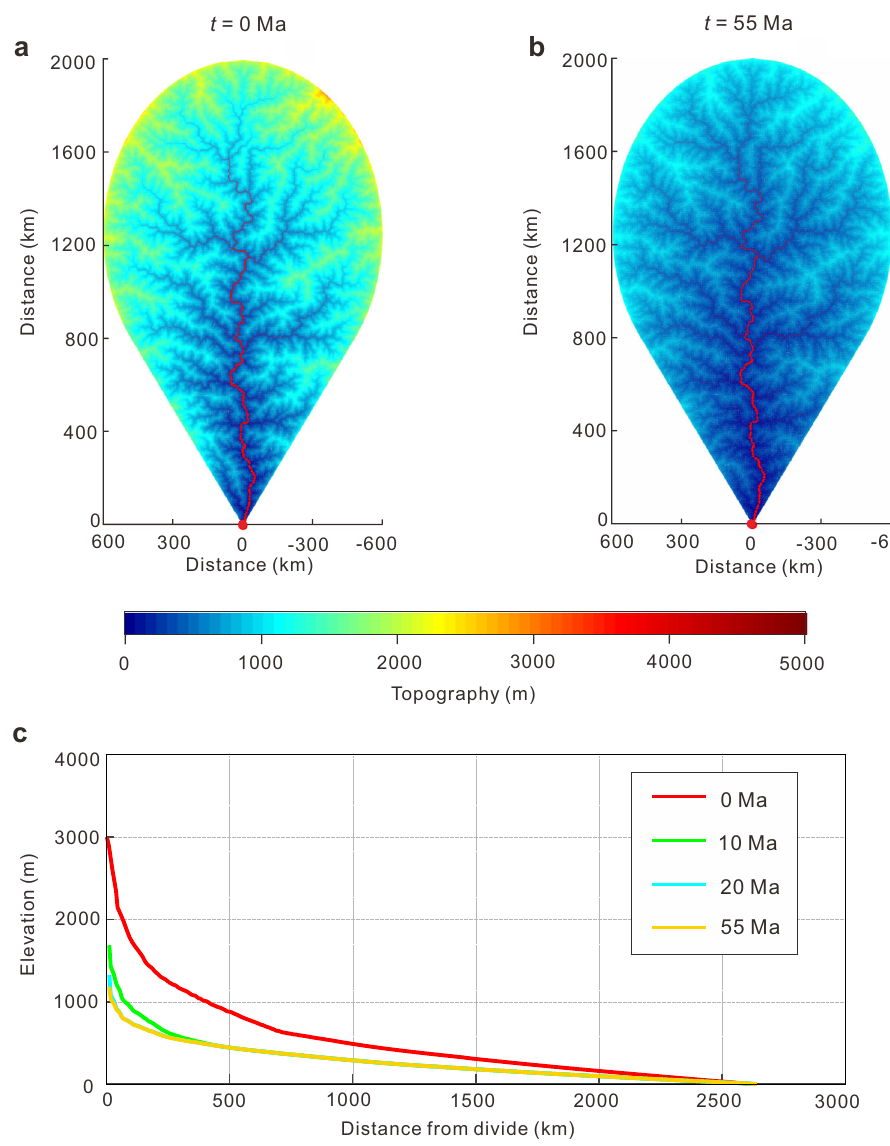
Fig. 5 Results of landscape evolution models illustrating the decay of relief over ~55 Ma. a Initial relief is 3000 m at 0 Ma. b Topographic relief is reduced to a regional low-relief topographic surface (< 1000 m) after 55 Ma. c Modelled change in elevation along the longitudinal pro fi le of the trunk river from the continental interior to base level at 0 Ma, 10 Ma, 20 Ma and 55 Ma. Model parameters are given in Supplementary Table